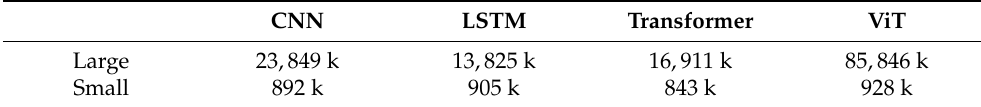
Table 2. Total trainable parameters for each neural network architecture. CNN